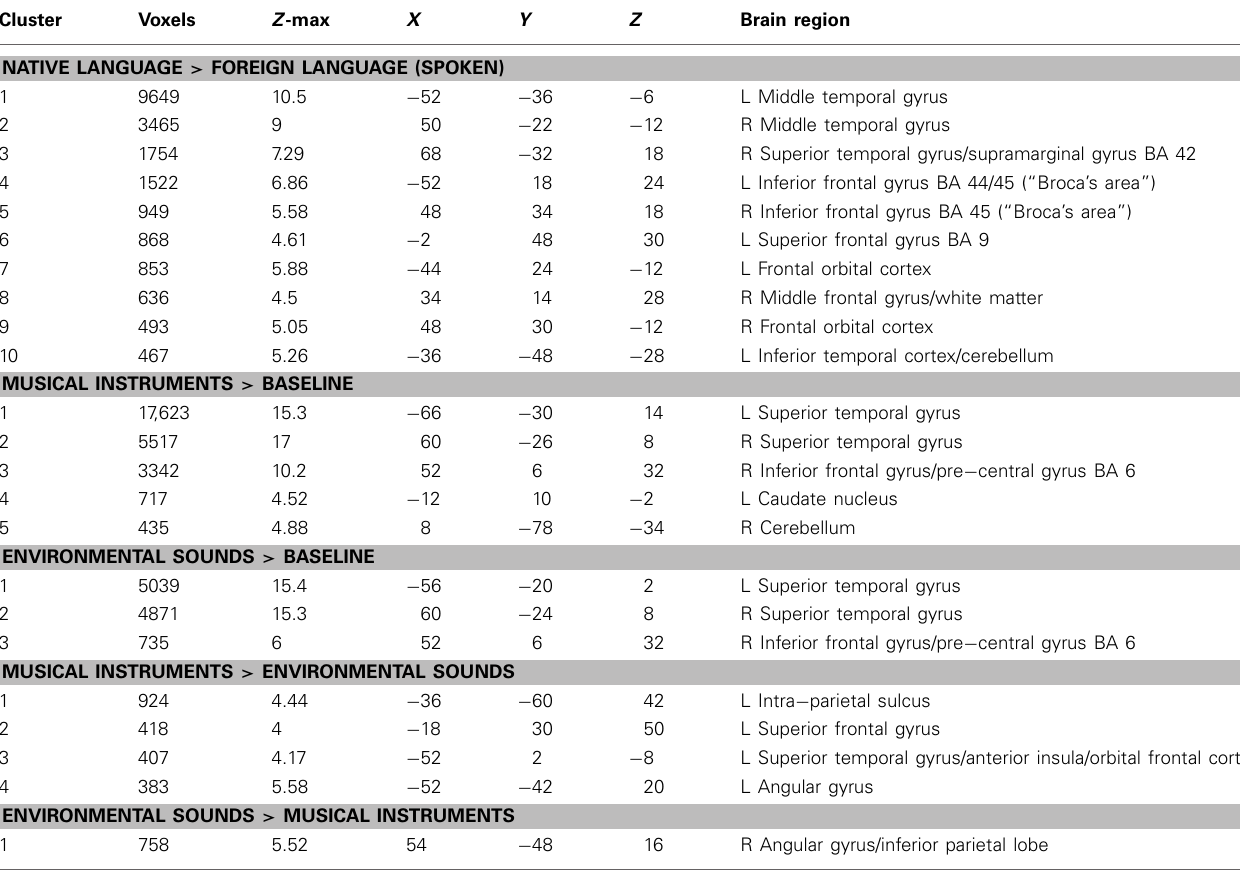
Whole brain Z-statistic values, MNI coordinates, cluster size, and brain regions are reported for each contrast of interest. Brain regions are based on the Harvard-Oxford Cortical Structural Atlas, the Juelich Histological Atlas, and Brodmann areas are reported from the Talairach Daemon when available.